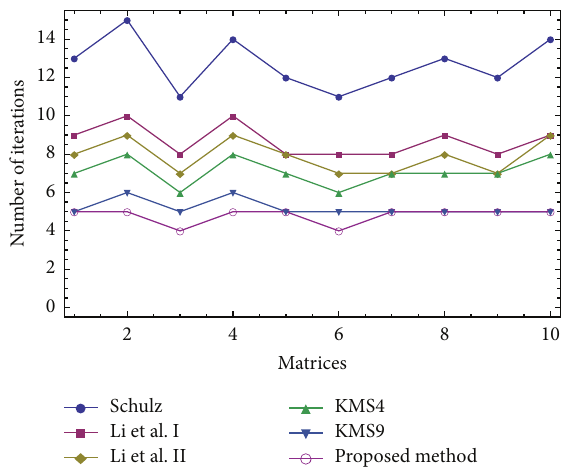
Figure 3: Comparison of the elapsed time for solving the Test Problem 1 using 𝑉 0 = 𝐴/‖𝐴‖ 2 ∞ .